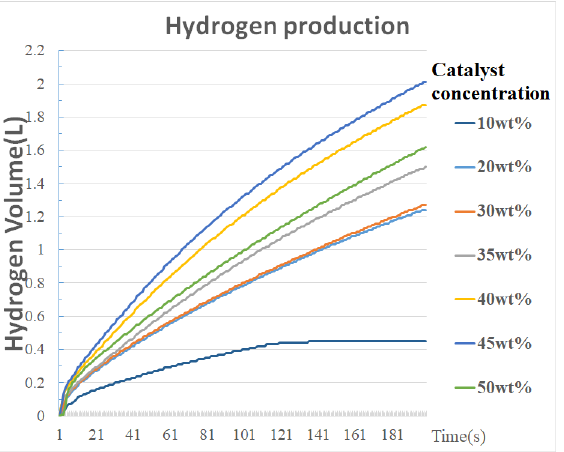
Figure 2. Comparison of the hydrogen production rates of the Co 2+ /Al 2 O 3 catalyst chelate concen- trations at a normal temperature of 25 °C.